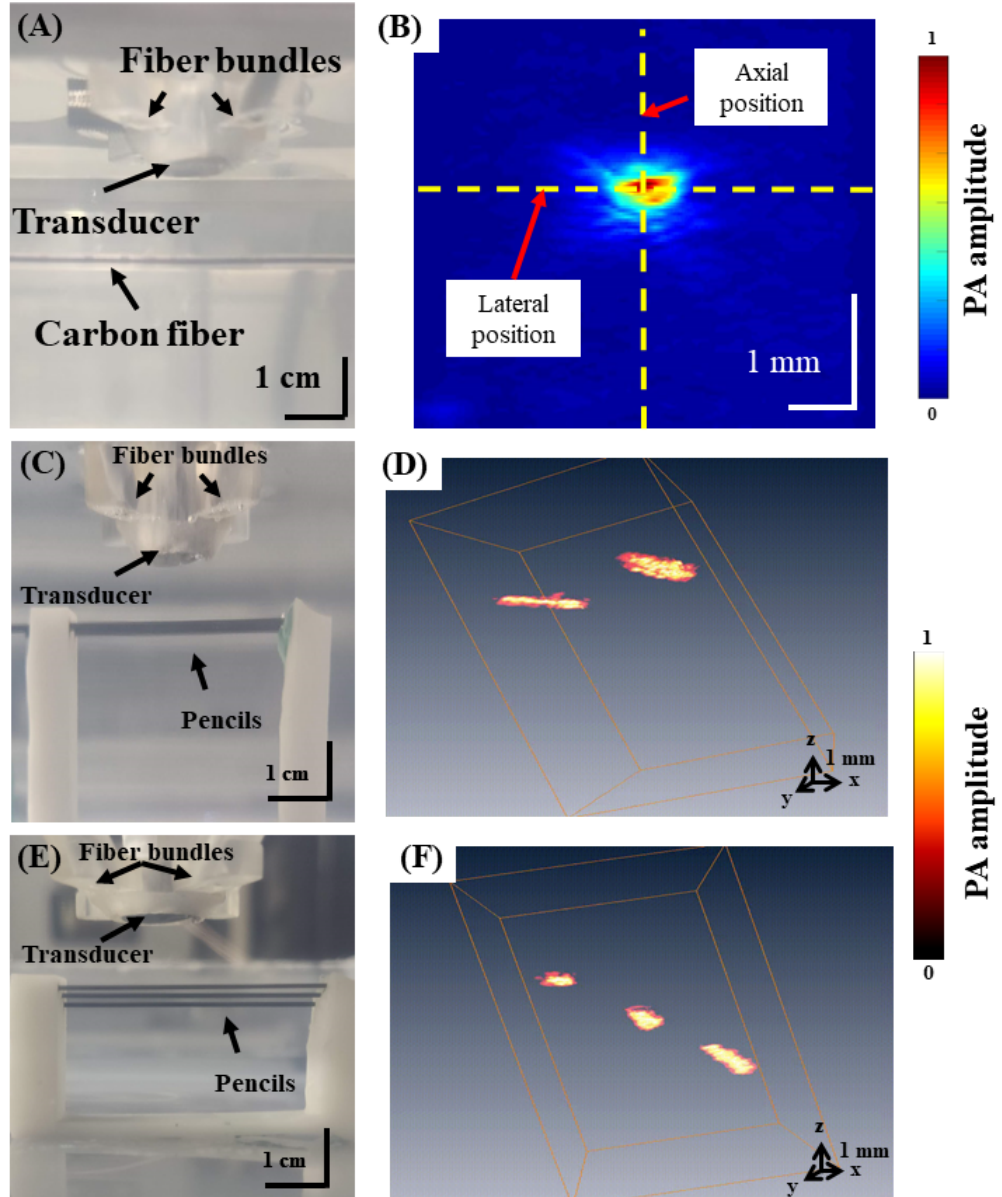
Figure 3. Performance tests for the axial and lateral resolutions of the developed hmPAI system using 79 μ m carbon